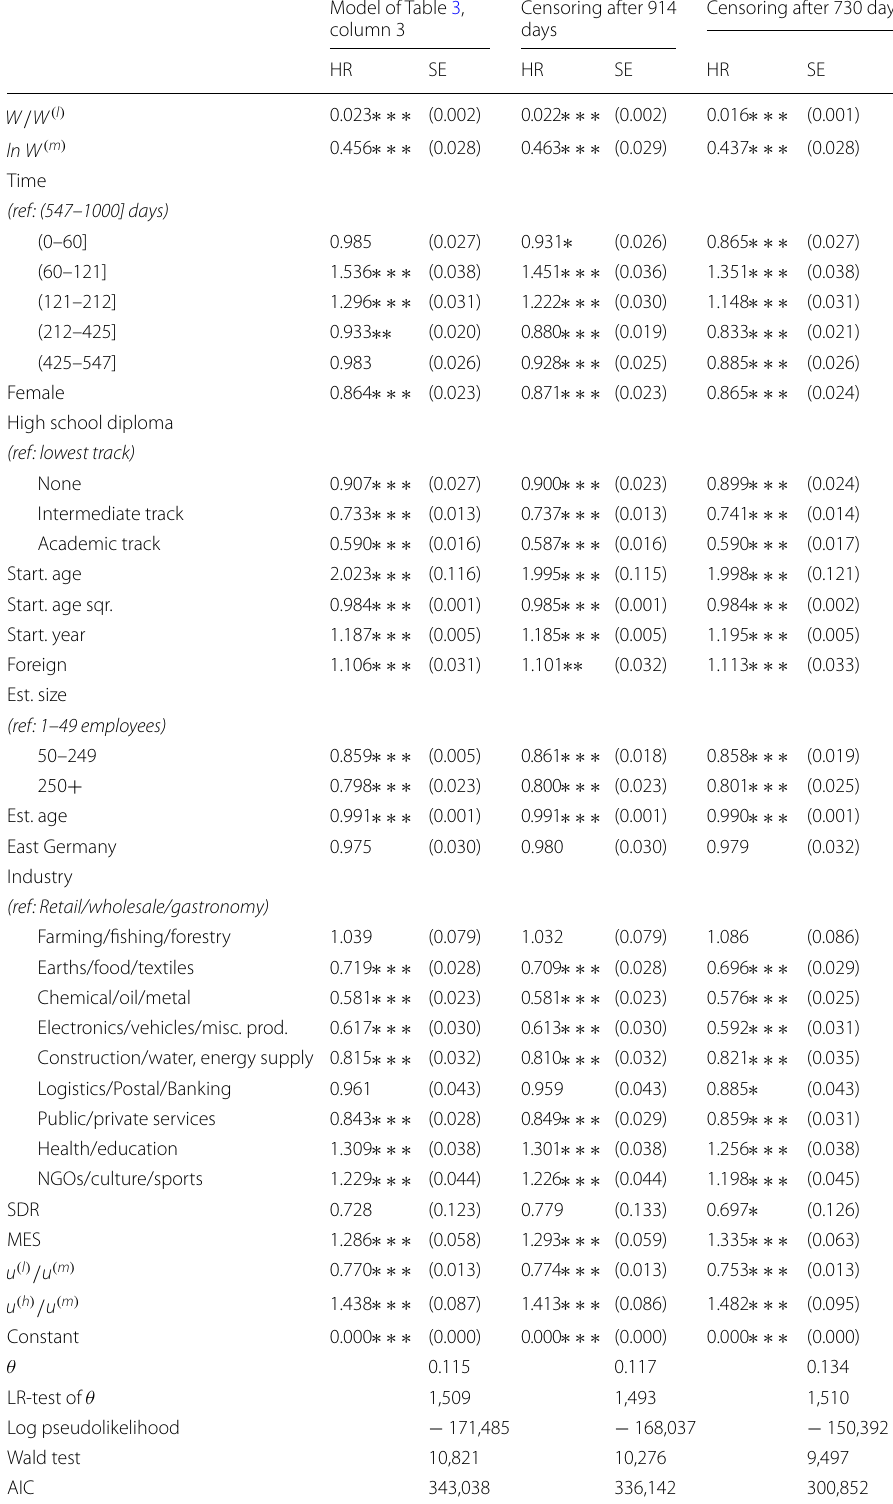
Table 8 Estimated hazard ratios for the piecewise exponential model of the apprenticeship non‑ completion hazard for different censoring